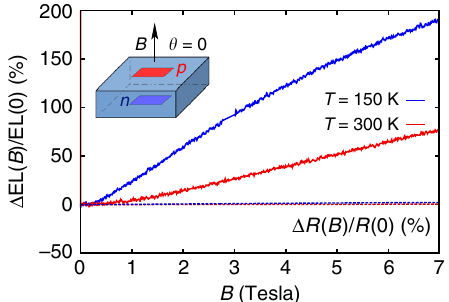
Fig. 3 Magneto-electroluminescence in silicon light-emitting devices. Comparison between MEL and MR effects in a vertical SiLED under a perpendicular magnetic fi eld (magnetic fi eld tilt angle θ = 0 relative to current lines) at 300 and 150 K, where Δ EL( B ) = EL( B ) − EL(0) and Δ R ( B ) = R ( B ) − R (0). The DC forward bias current was 10